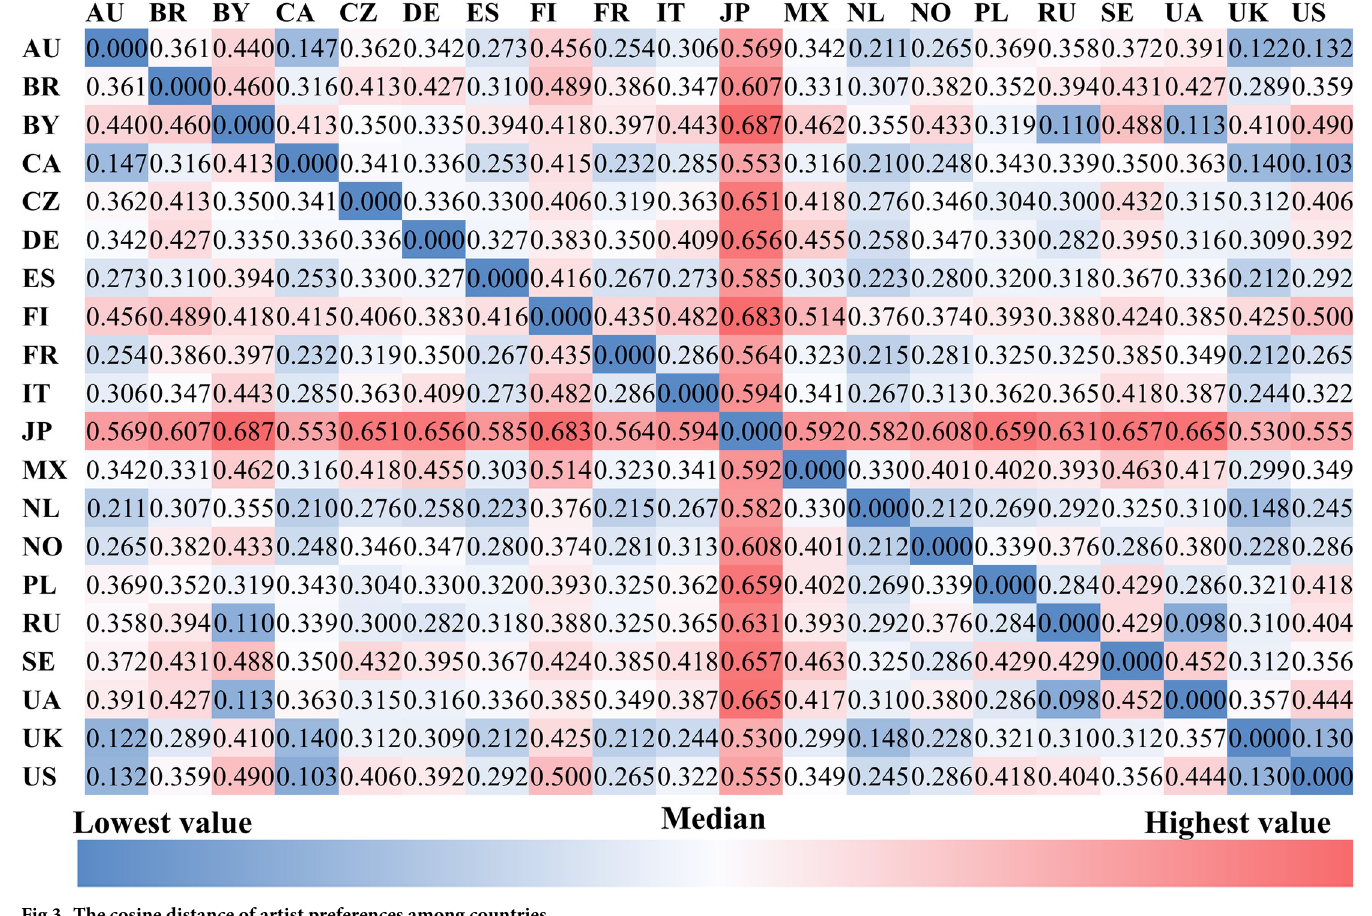
Fig 3. The cosine distance of artist preferences among